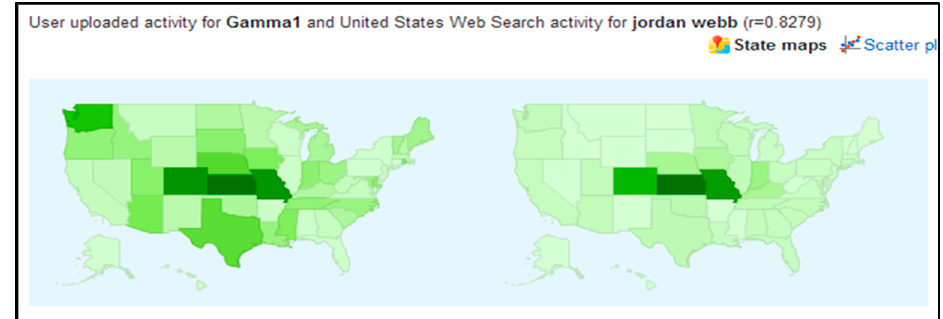
Figure 2. Screenshot of identified spurious correlation from Google Correlate. Gamma1 is a randomly generated cross-state distribution resulting from draws of the gamma (1, 1) distribution.